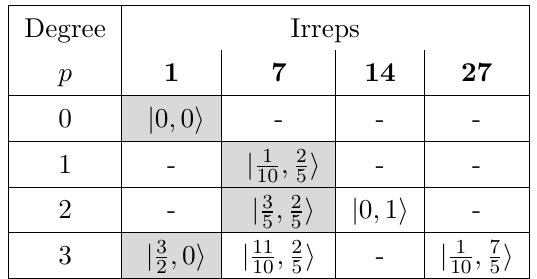
Table 1 . Correspondence between differential forms and G 2 CFT